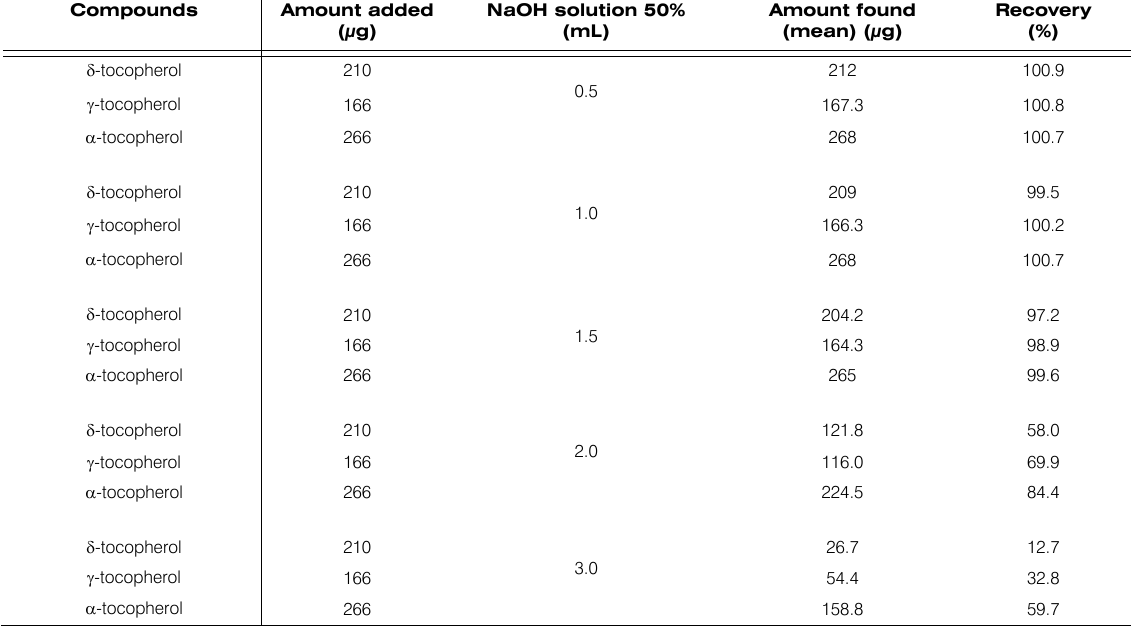
Table 3. The influence of NaOH addition on the tocopherols recovery Compounds